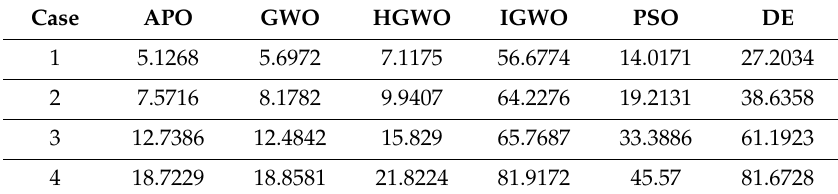
Figure 13. The distribution of the operation results (30 times of testing) of each case. ( a ) case 1; ( b ) case 2; ( c ) case 3; ( d ) case 4. Table 18. The average time of each algorithm in each case (unit: